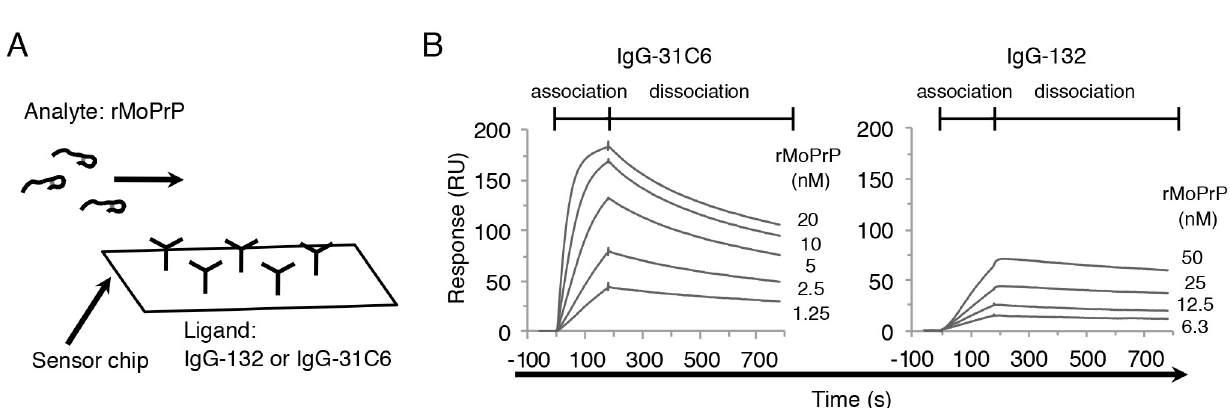
Fig 5. Binding affinity of authentic mAbs. (A) Relationship between ligand and analyte. IgG-132 or IgG-31C6 was directly immobilized at approximately 1,000 RU on the surface of a CM5 sensorchip as a ligand. The rMoPrP was passed over the surface of the chip as an analyte. (B) Multi-cycle kinetics analysis. SPR sensorgrams for the binding of anti-PrP mAb to rMoPrP were obtained using 2-fold serial dilutions of rMoPrP (1.25–20 nM for IgG-31C6 and 6.3–50 nM for